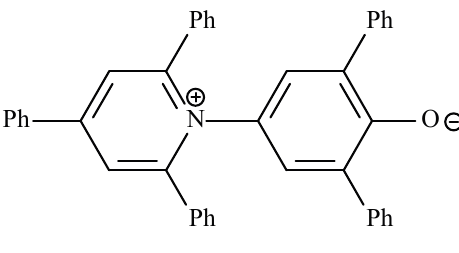
Figure 2. 2,6-Diphenyl-4-(2,4,6-triphenyl-1-pyridinio)phenolate (Reichardt’s